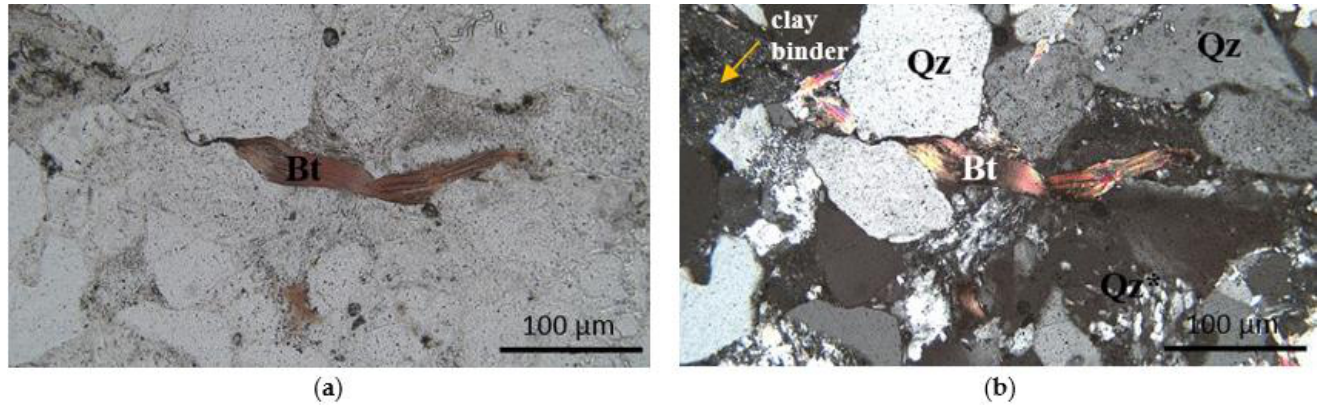
Figure 9. Biotite (B t ) and quartz (Q z ) surrounded by clay binder and microcrystalline quartz (Q z *): ( a ) one polar; ( b ) crossed polars—100× magnification.